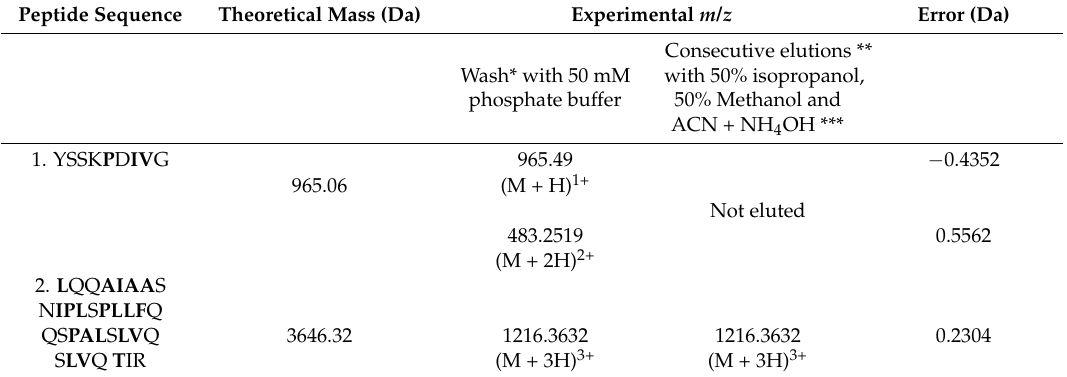
Table 2. Analysis by UHPLC-Q-ToF of wash and elutions from FCSNP after incubation with model peptides. Peptide